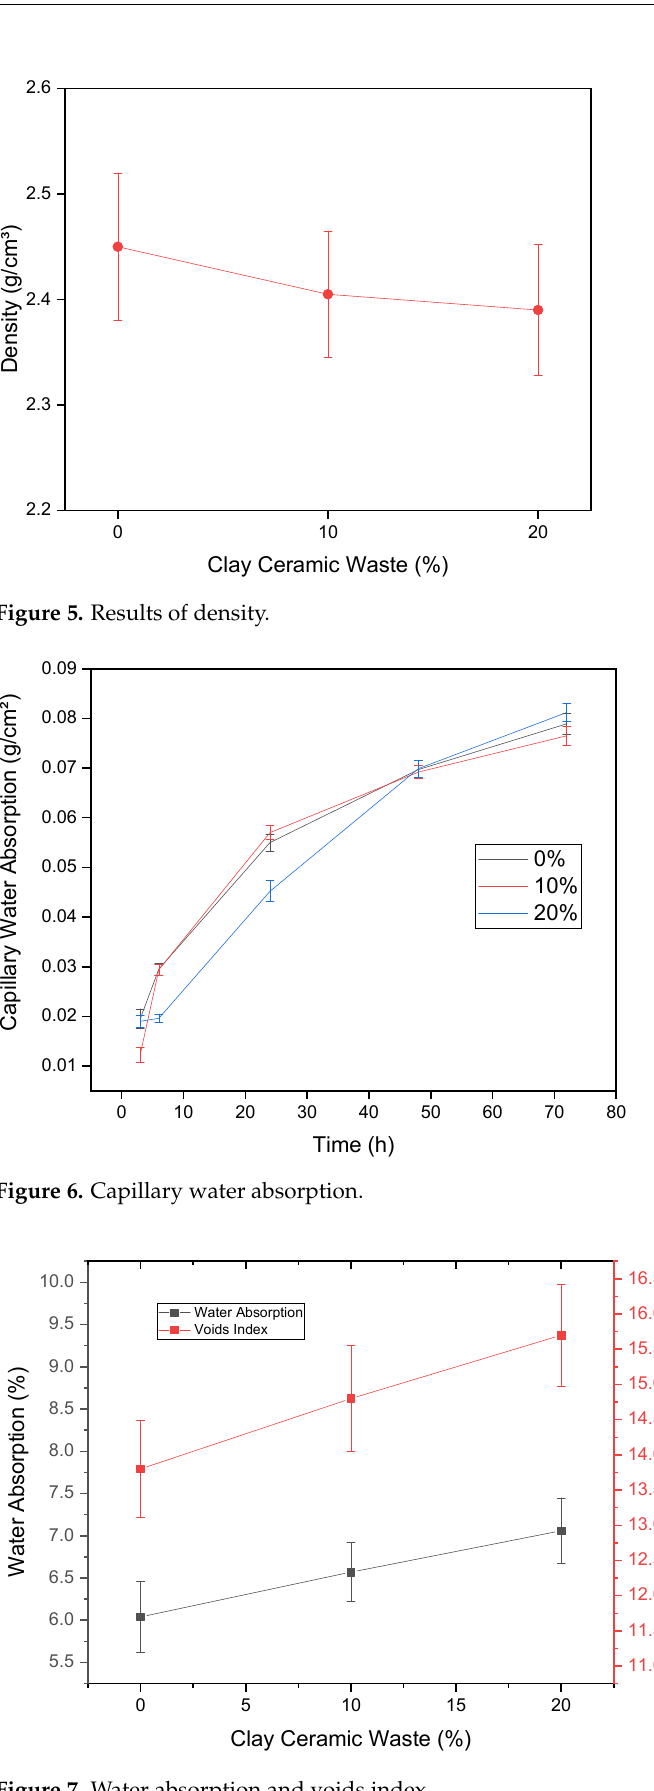
Figure 7. Water absorption and voids index.